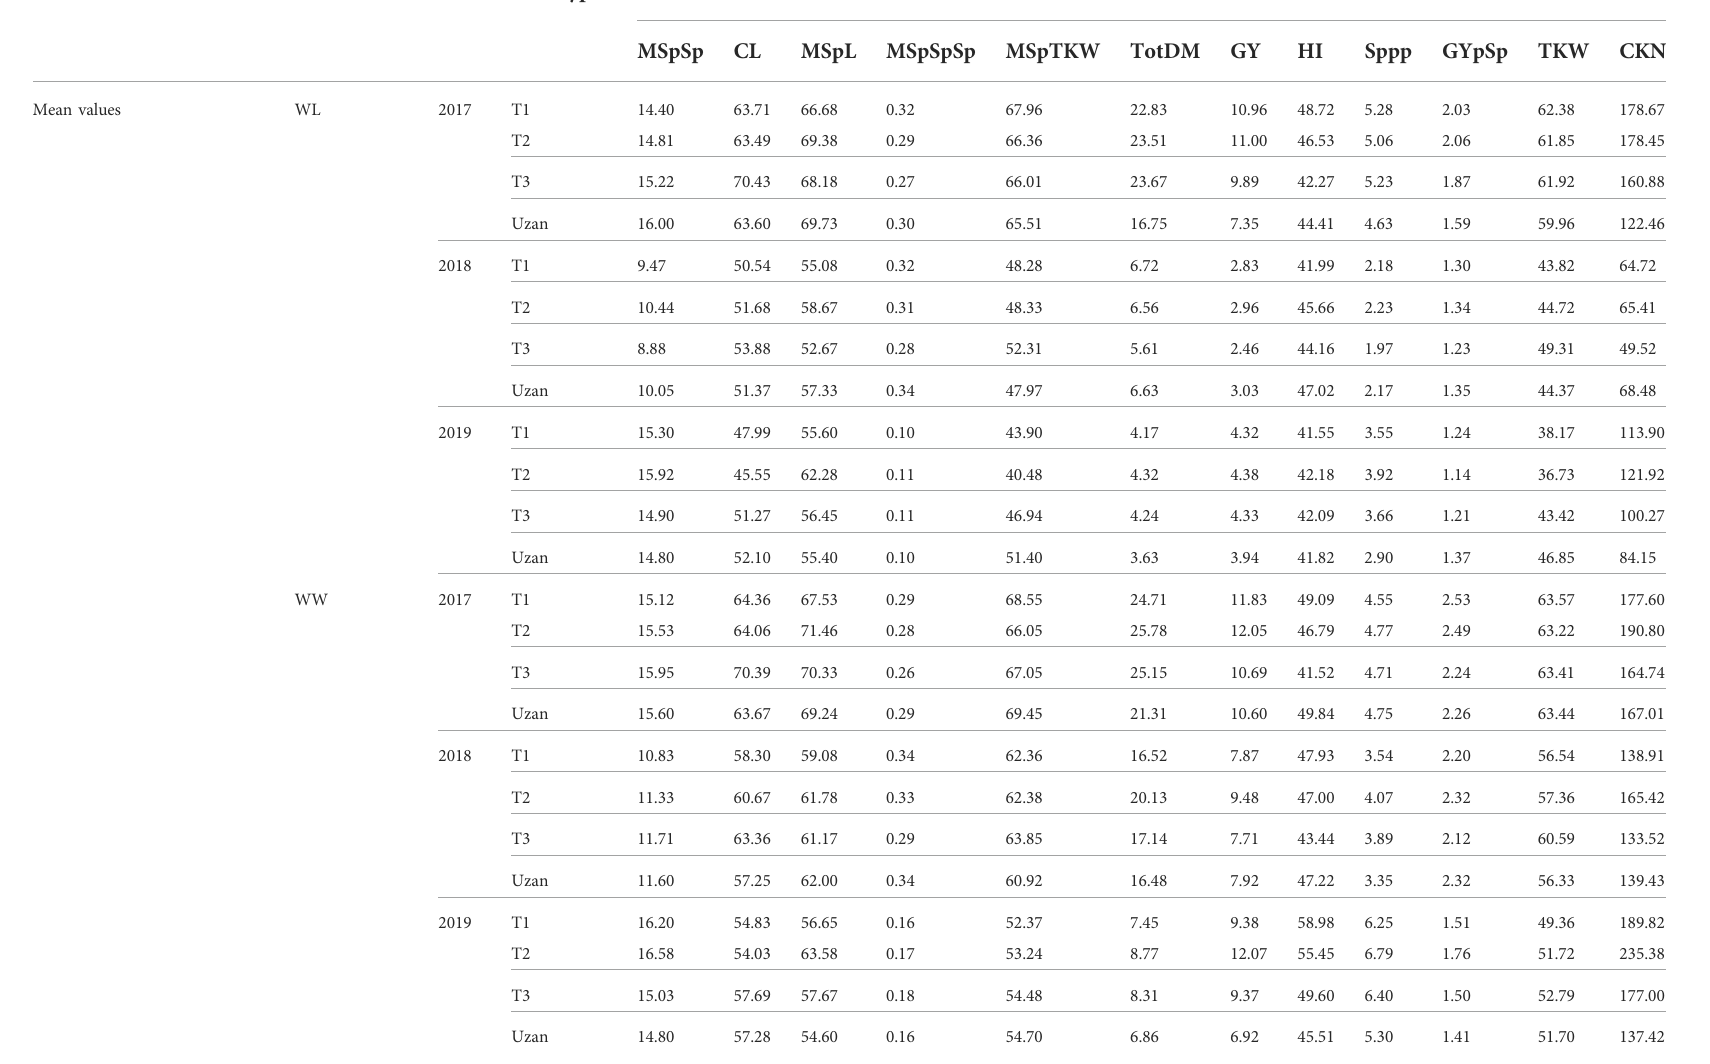
TABLE 5 Mean values of segmental sub-NILs, carrying different alleles of the iSelect marker Tdurum_contig27976_414 and